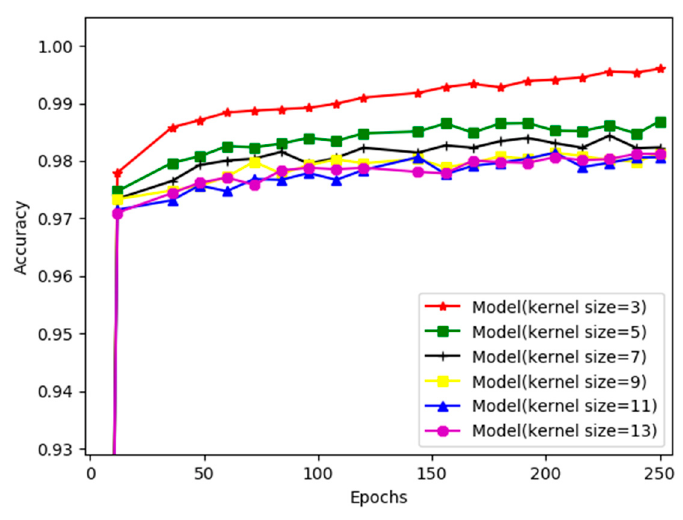
Figure 7. Experimenting with various kernel sizes to construct the optimal neural network. The x - and y -axes represent the number of epochs (250) and training accuracy, respectively.